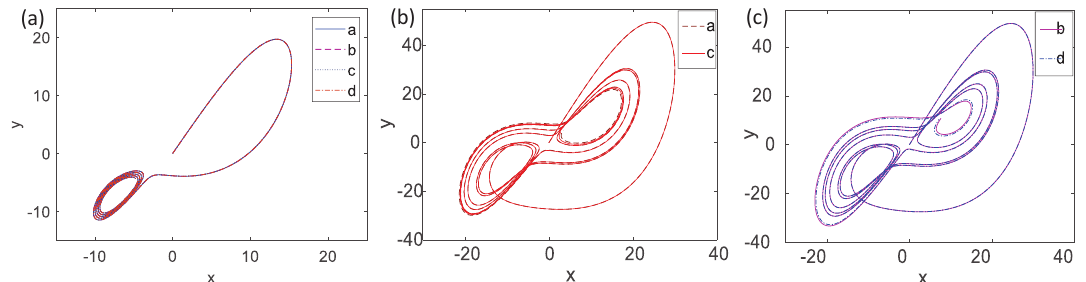
Figure 3. The phase space trajectory diagram of the Lorenz system running in multi-periodic state ( a ) and chaotic state ( b ) and ( c